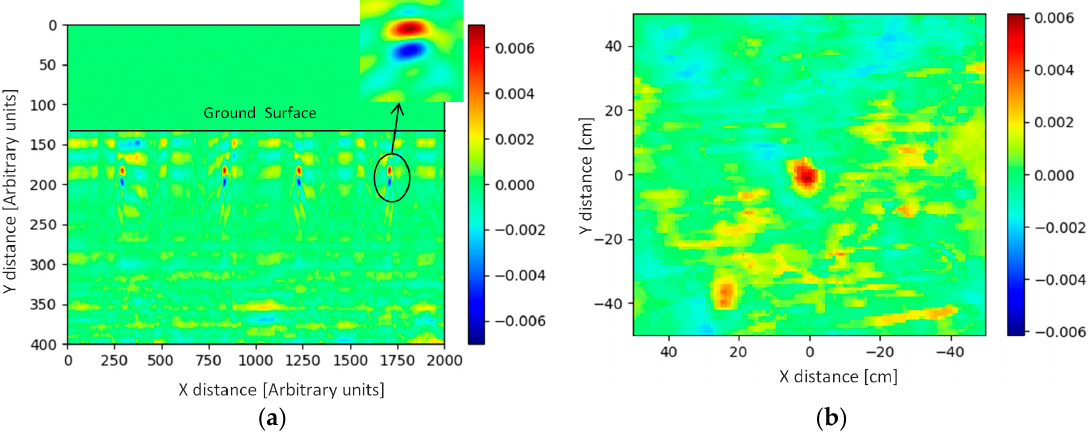
Figure 13. Results for PMA3 buried at 5 cm (measurement): ( a ) B scan; ( b ) C scan.